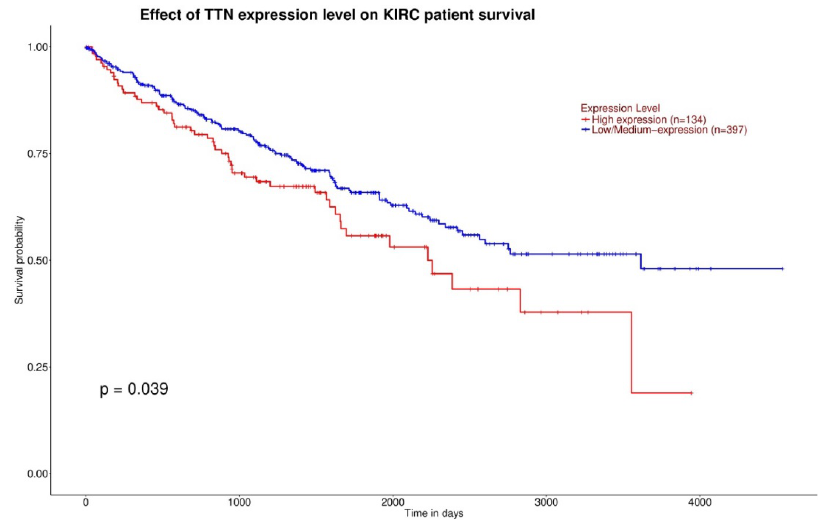
Figure 4. Kaplan-Meier curves showing statistically significant difference ( p < 0.05) of survival between high TTN expression and low/medium TTN expression (respectively red curve and blue curve).